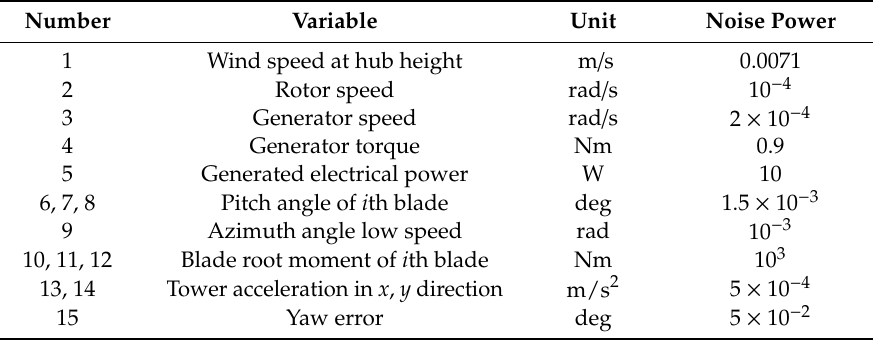
Table 1. Available variables.